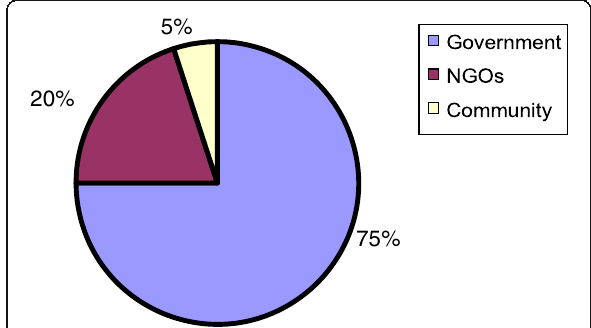
Figure 5 Most suitable development agent to initiate adaptive strategies